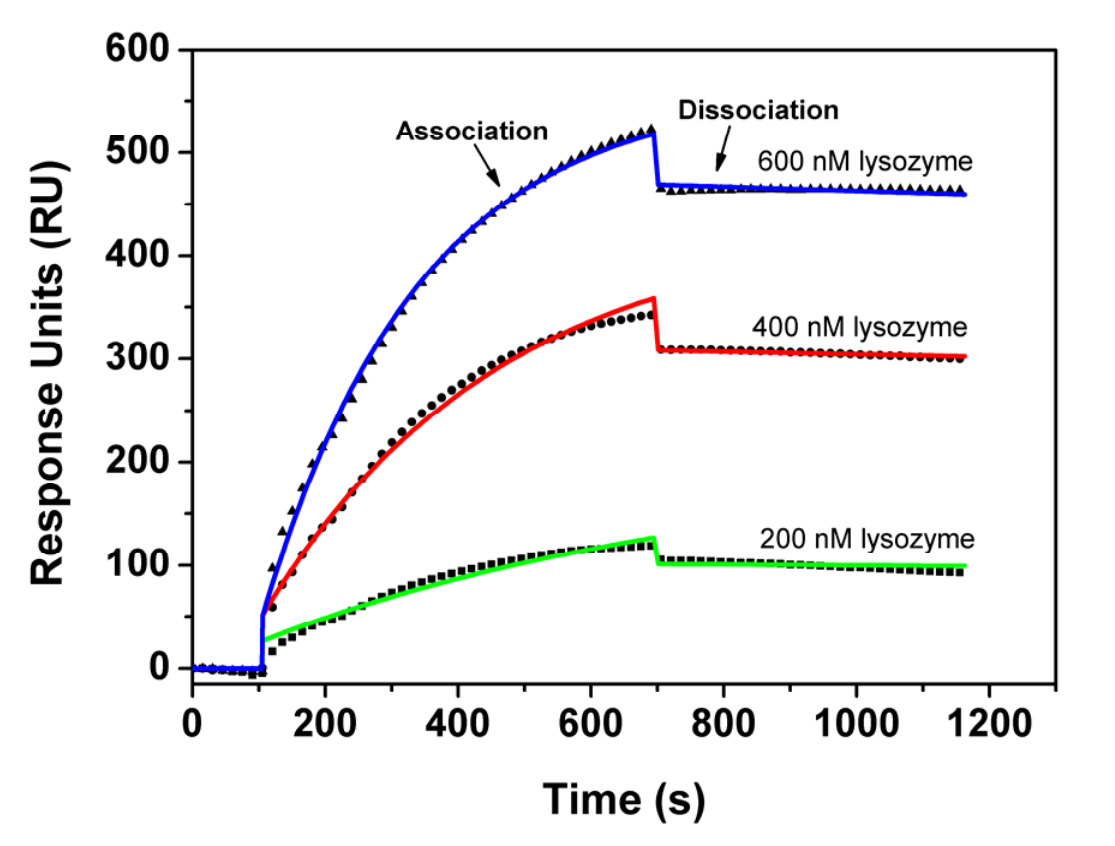
Figure 5. Global association/dissociation analysis of the kinetic SPR data on the binding interaction of lysozyme and Apta1. Biotinylated aptamers (0.5 µM) were immobilized on a sensor chips and the protein solutions (200, 400, 600 nM) were injected over the